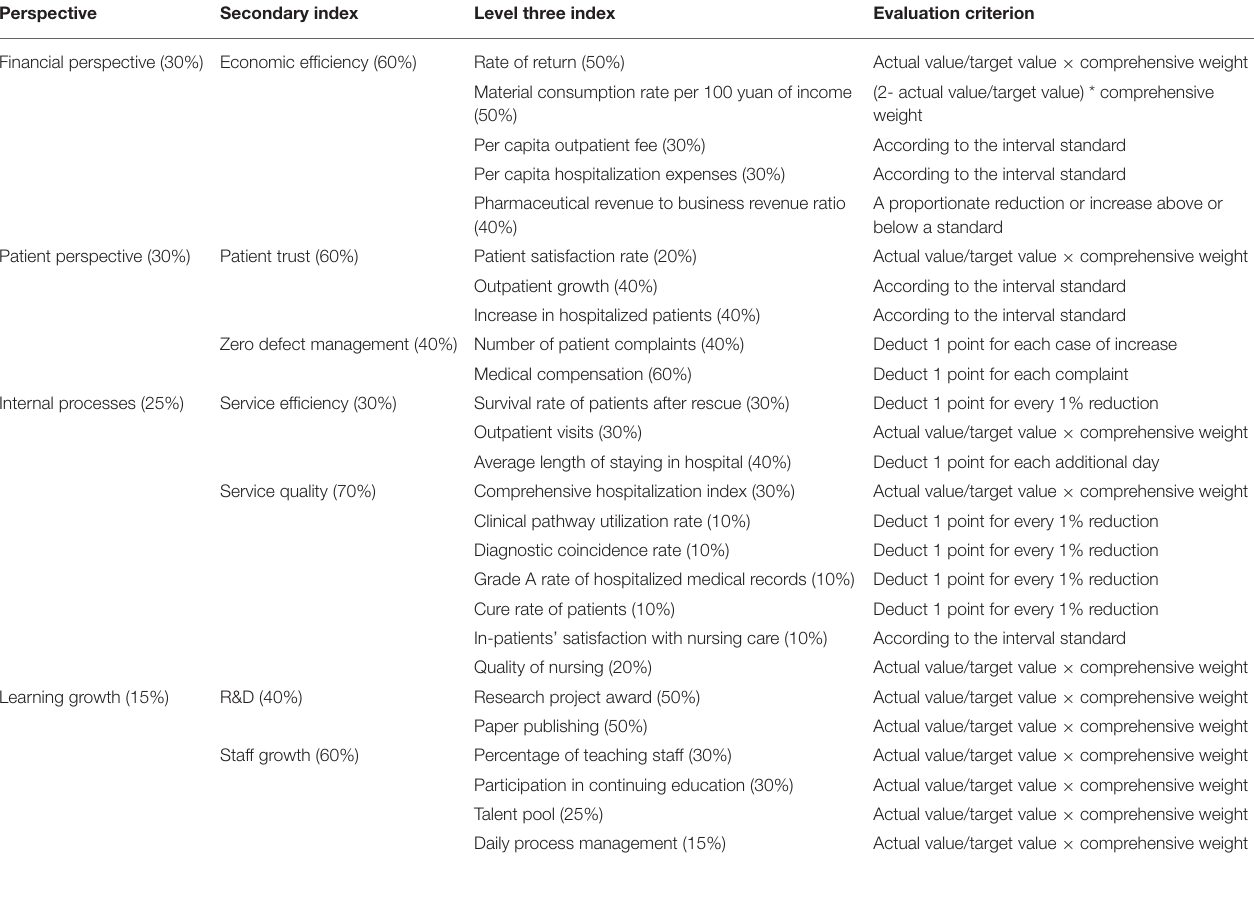
TABLE 8 | Formulation of B departmental performance